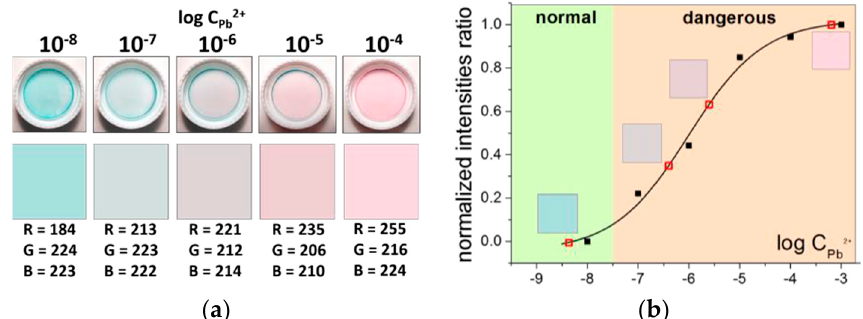
Figure 3. ( a ) Photographs of the standard Pb2+-selective optodes and the respective scale elements. ( b ) The results of sample determinations: with the developed scale (photographs), quantitative determination with the reference methods (empty symbols). Solid symbols and curve: calibration data. Optode: 10 mM/kg ETH5418, 10 mM/kg NaTFPB, 60 mmM/kg Pb IV, pH 6.25.